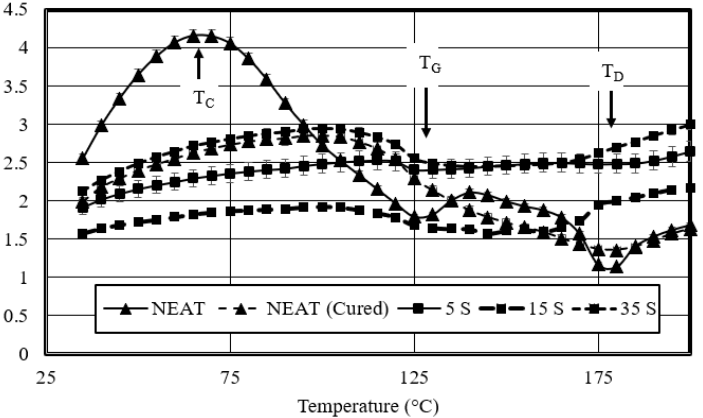
Figure 11. Specific heat capacity (C P ) of as-printed, neat-cured, and carbonated samples. Error bars of ± 2%.